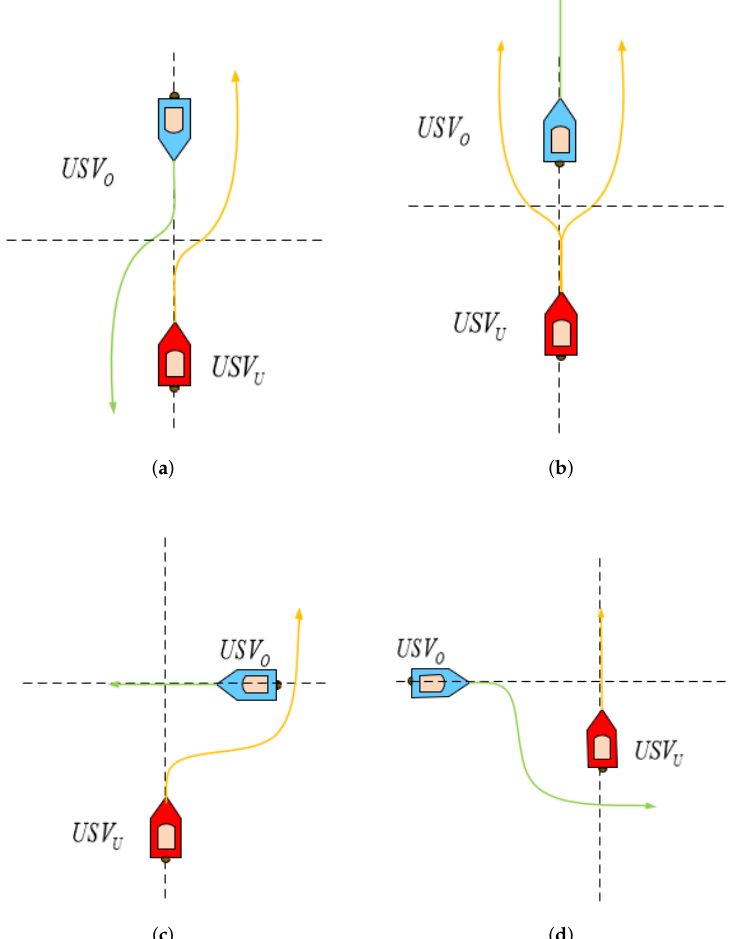
Figure 2. The encounter situations of USVs under the COLREGs. ( a ) Head-on. ( b ) Overtaking. ( c ) Crossing-give-way. ( d )